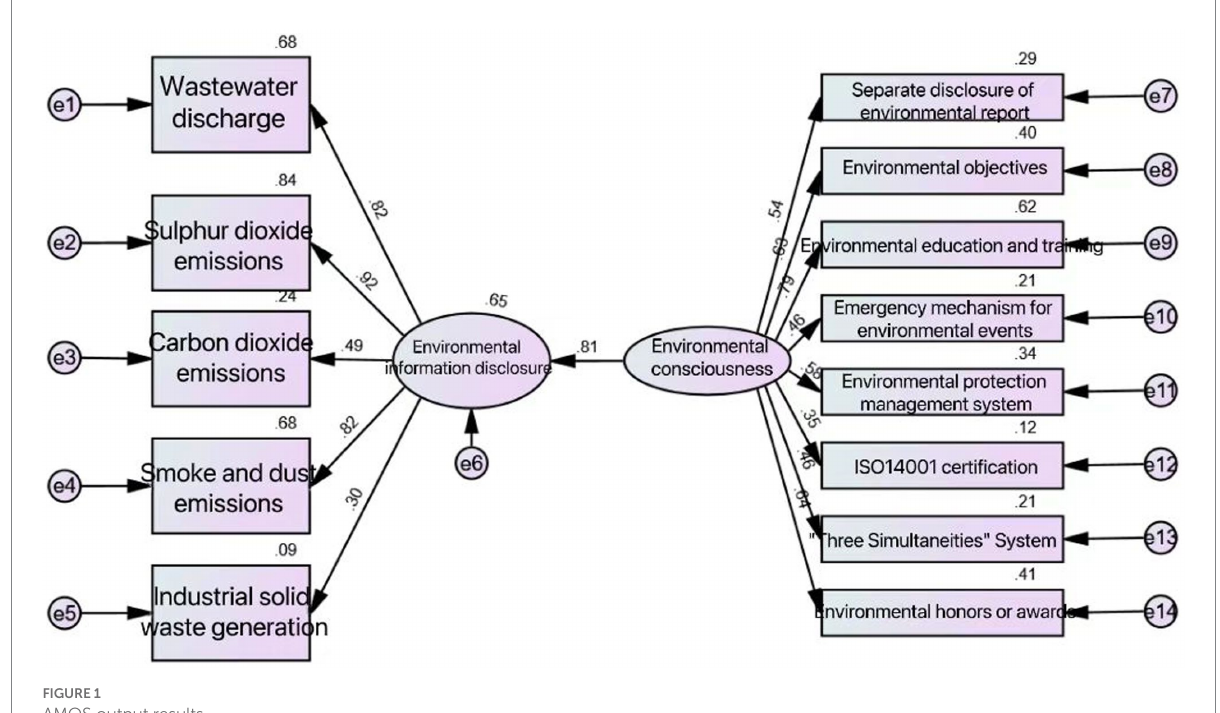
FIGURE 1 AMOS output